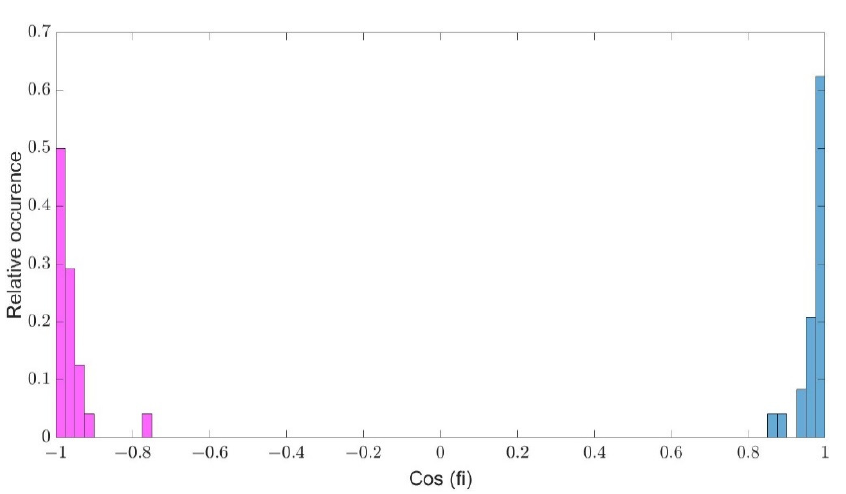
Figure 12. Histogram of angle differences ( cos𝜑 ) between the measured vectors b and b ref . Blue for rotation in OK direction, magenta for NOK direction.